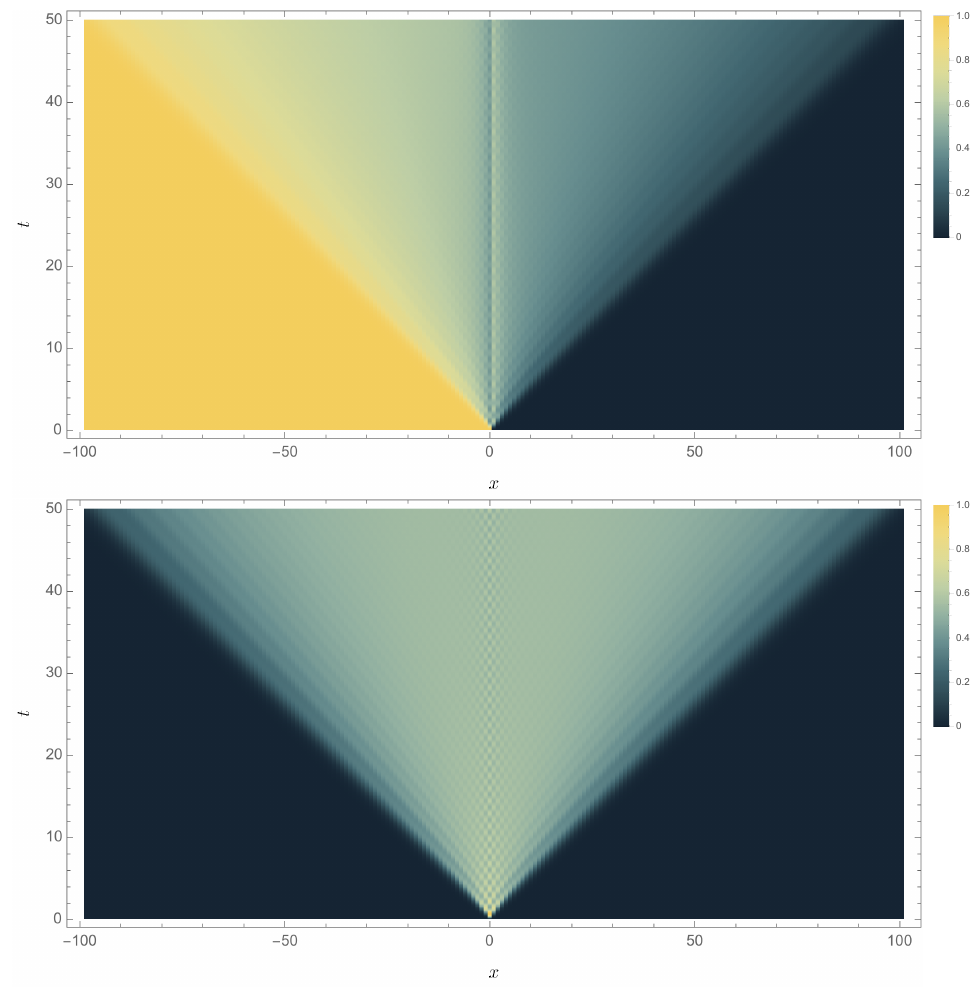
Figure 1: Particle density n ( x , t ) ( top ) and current J ( x , t ) ( bottom ) as functions of the position x and time t for the inhomogeneous quench protocol considered in Sec.